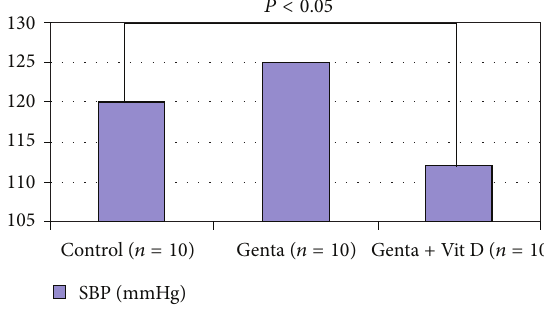
Figure 1: Blood pressures.